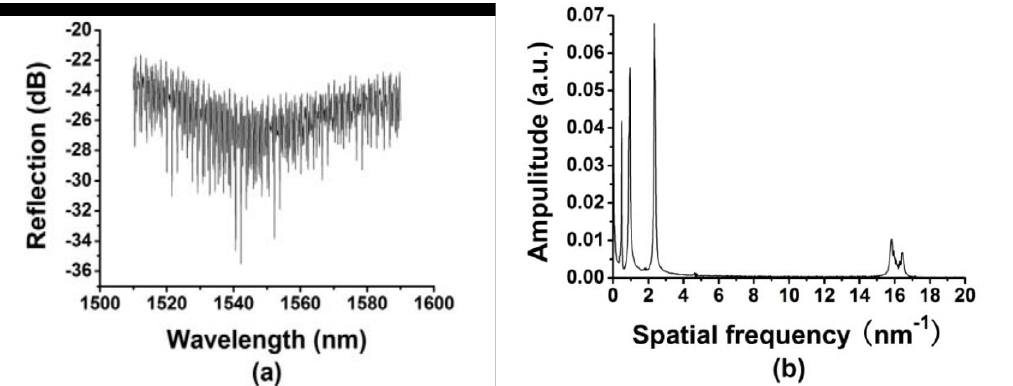
Figure 6. ( a ) Reflected spectrum of four multiplexed sensors with different length of GI-MMF and ( b ) corresponding FFT